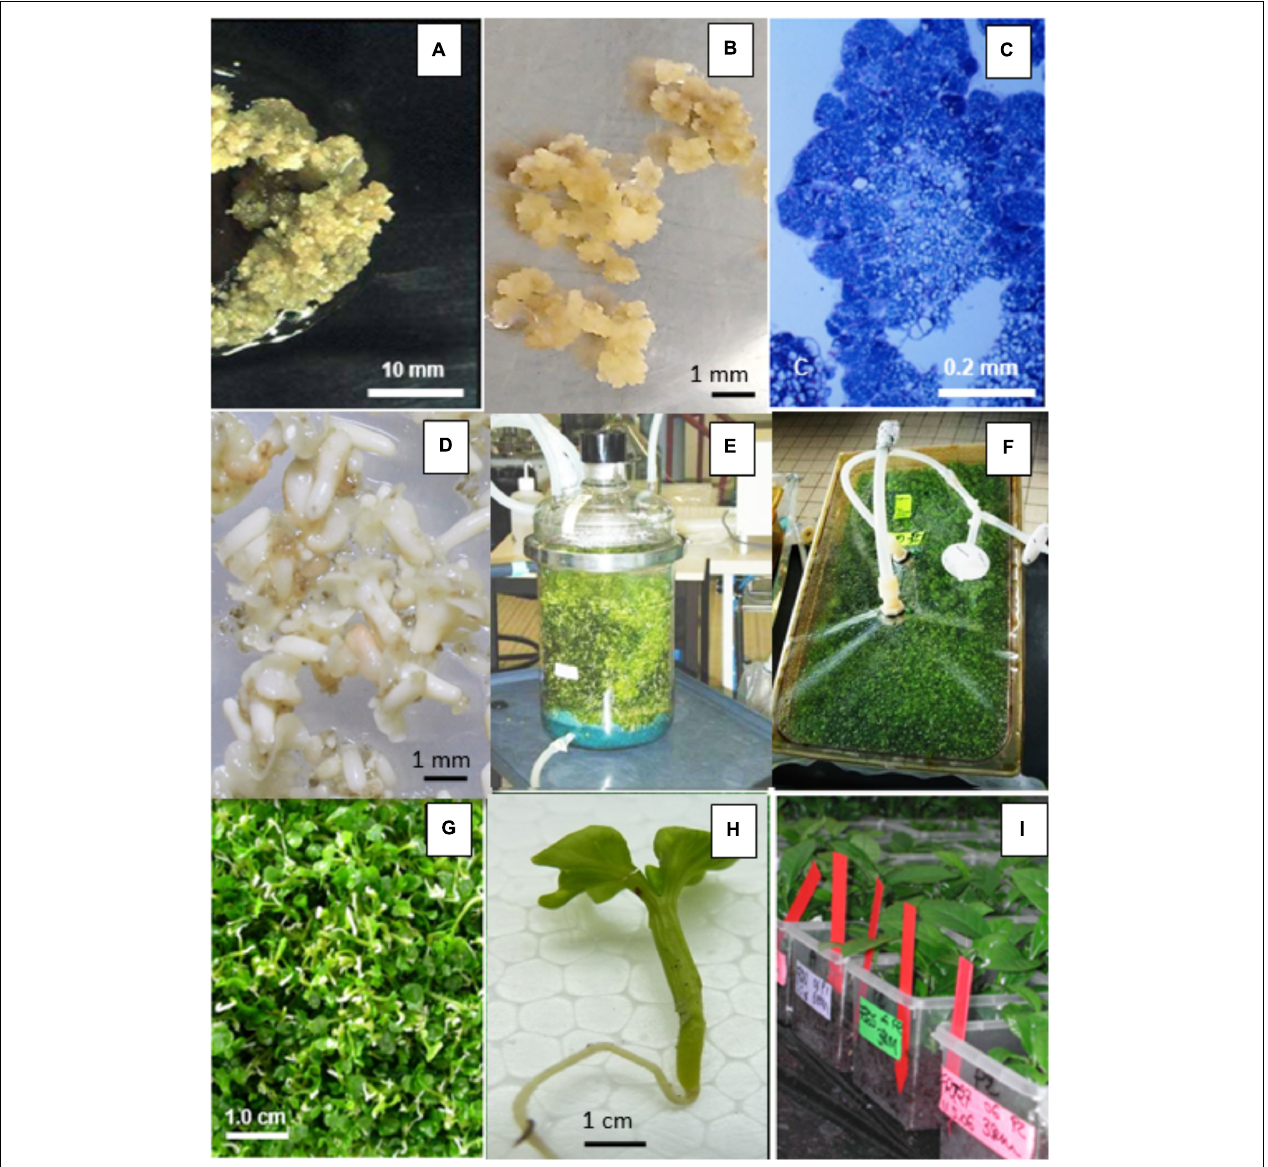
FIGURE 6 | Robusta somatic embryogenic tissues at different stages. (A) Primary embryogenic callus on a leaf explant, (B) embryogenic calli, (C) histological view of an embryogenic clump, (D) expression: torpedo-stage embryos at the end of the phase, (E) pre-germination: 10 L glass temporary immersion bioreactor (upper recipient), (F) Pre-germination: 10 L Box-in-Bag disposable bioreactor (upper recipient), (G) pre-germination: aspect of the cotyledonary-stage embryos, (H) selected cotyledonary embryos (pre-germinated embryos), (I) ex vitro germination test in the Nestlé R&D Tours